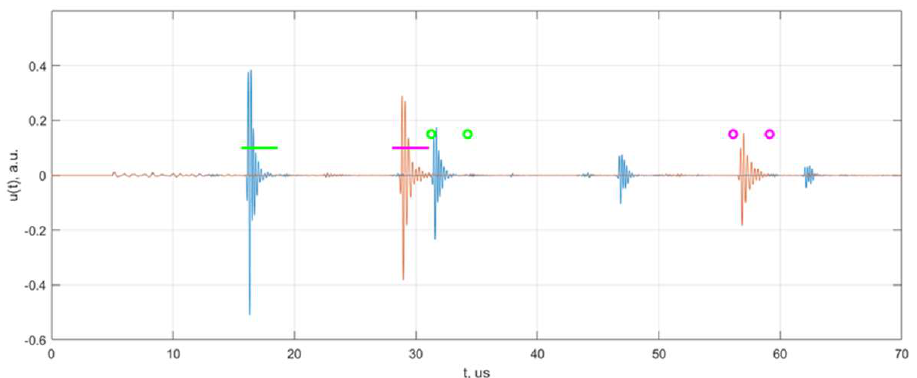
Figure 6. The measured signals of longitudinal (blue) and shear (red) waves. Horizontal lines indi-